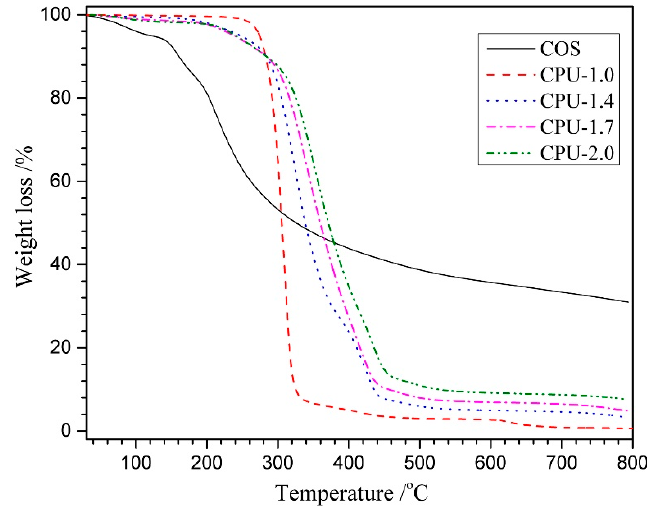
Figure 4. Thermogravimetric analysis (TGA) curves of COS powder and CPU films with different COS content. COS